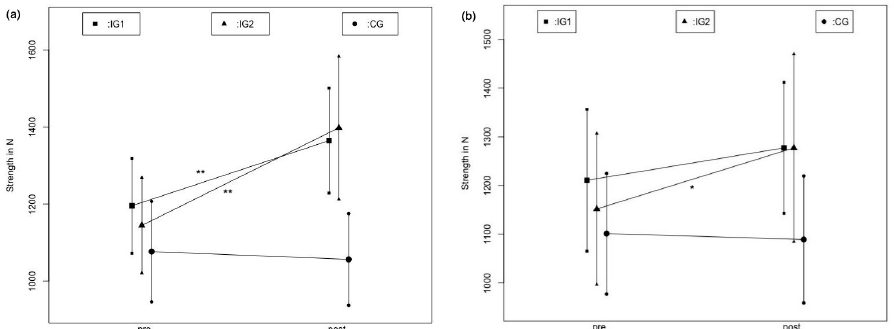
Figure 3. Comparison of maximum strength in pre- to post-test between IG1il, IG2il and CG ( a ) as well as between IG1cl, IG2cl and CGr ( b ). ** = p < 0.001, * = p < 0.05 for difference to control group .